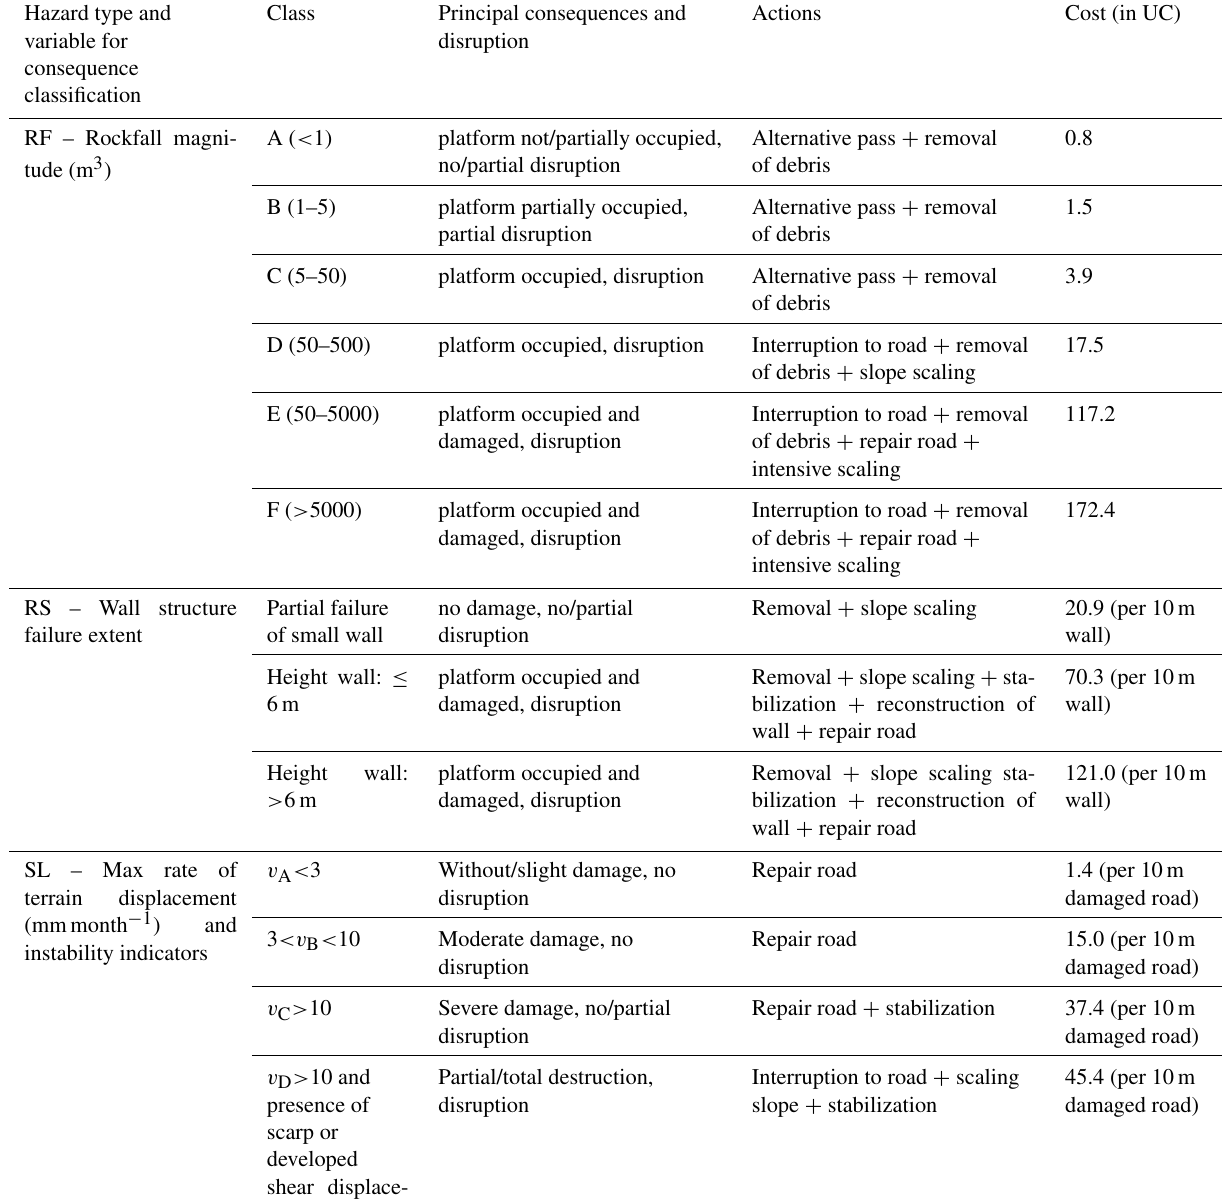
Table A1. Consequence classification and costs for each hazard type (source of costs: Ikerlur and Gipuzkoa Provincial Council). Hazard type